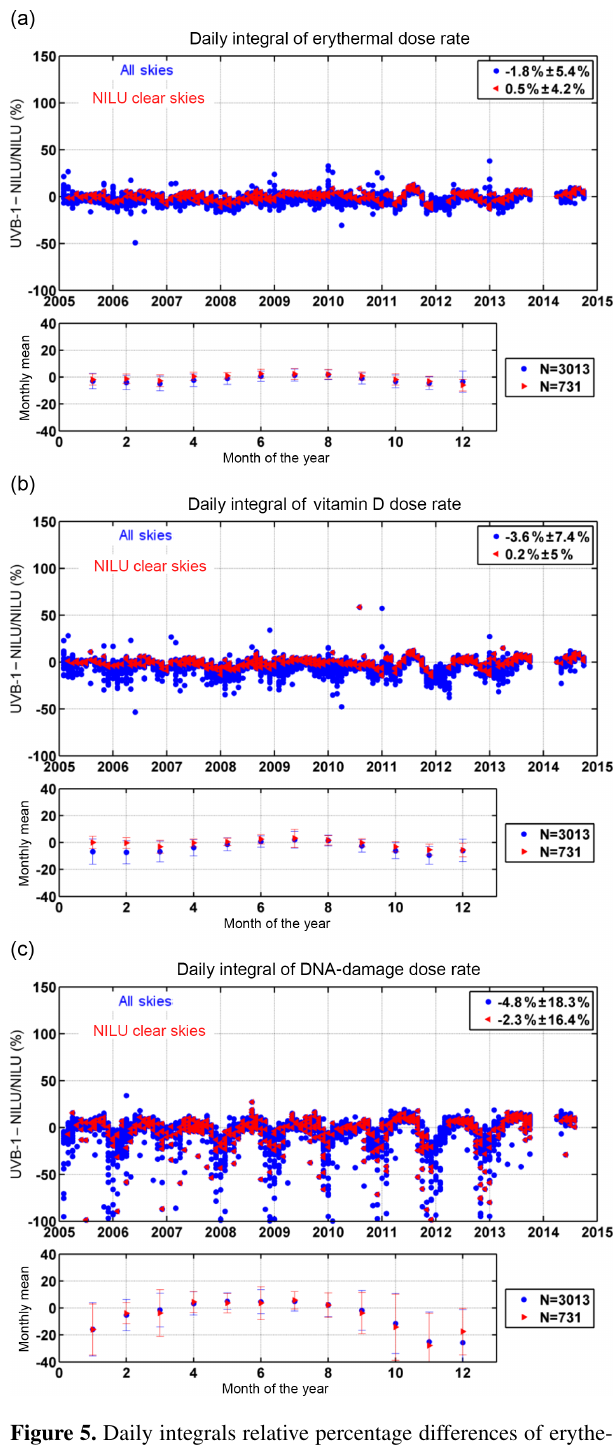
Figure 5. Daily integrals relative percentage differences of erythe- mal (a) , vitamin D (b) , and DNA-damage (c) doses estimates from the UVB-1 and NILU103 radiometers (upper panel) and the same datasets averaged on a monthly basis along with the 1 σ error bars (lower